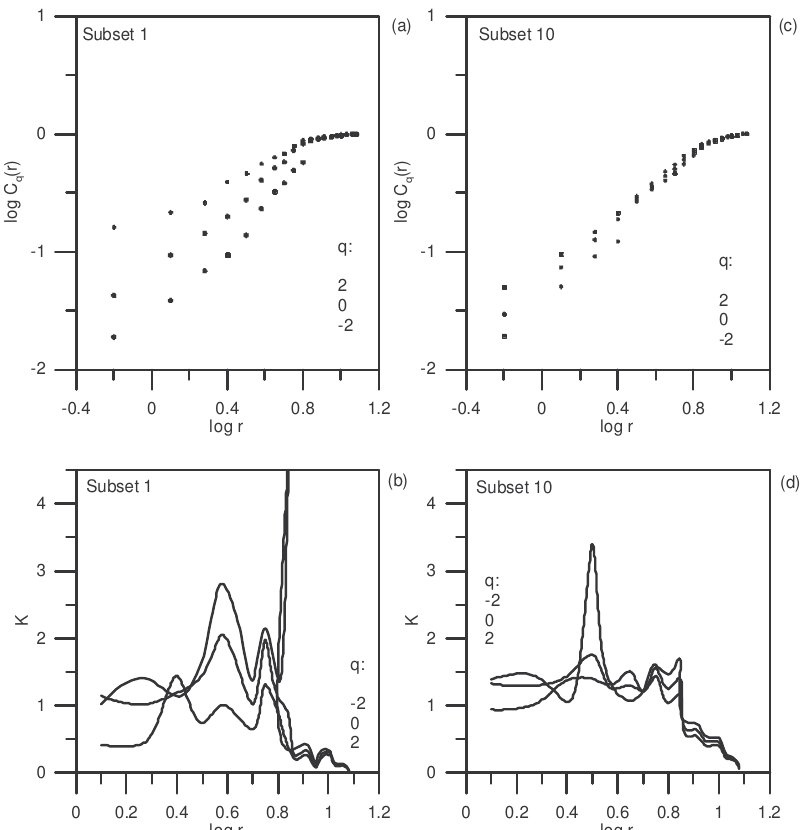
Fig. 3. (a) log C q (r) vs. log r for q = 2, –2 for subset S1; (b) log C q (r) vs. log r for q = 2, –2 for subset S10; (c) K vs. log r for subset S1; (d) K vs. log r for subset